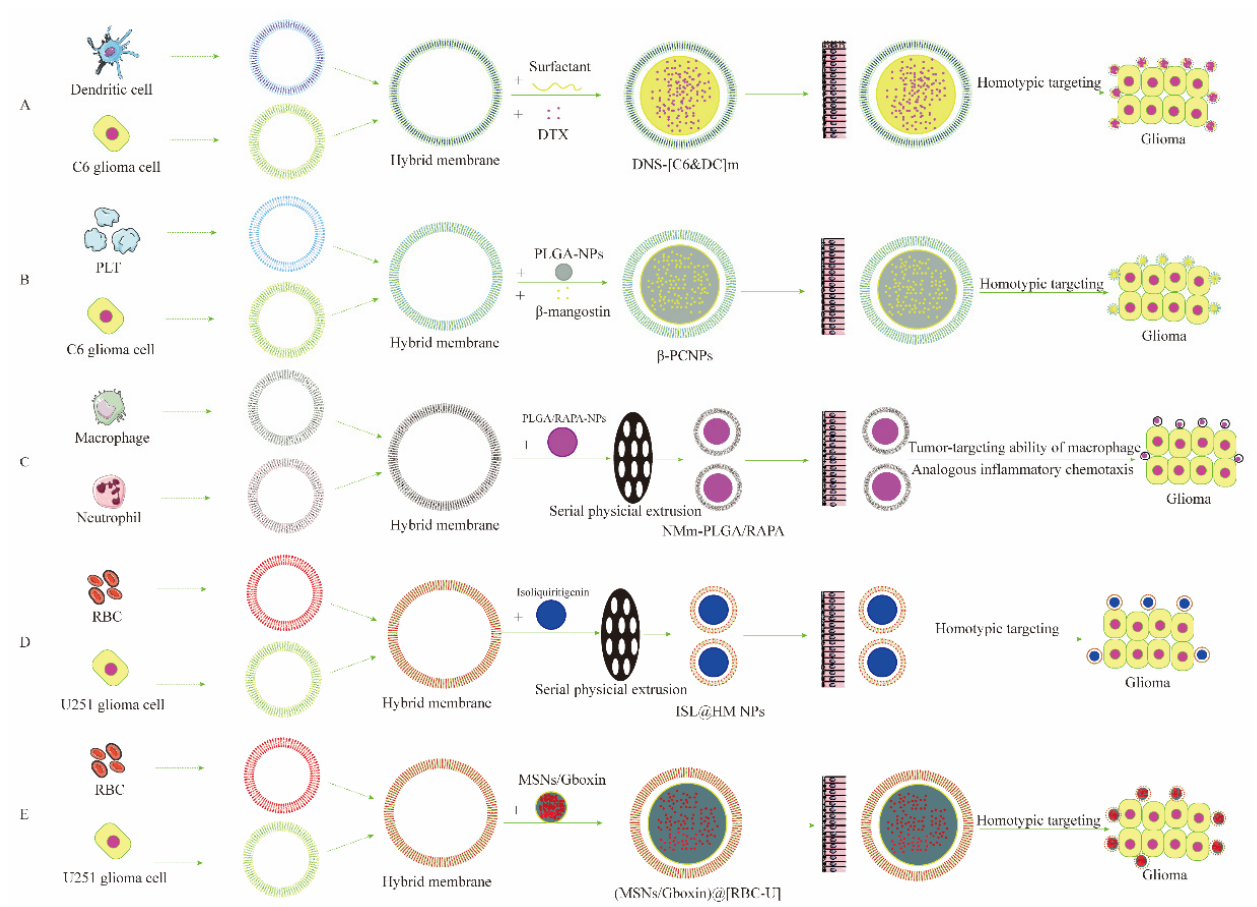
Figure 3. The preparation and characterization of hybrid-cell-membrane-coated nanoparticles for ND drug delivery. ( A ) The preparation and characterization of DNS-[C6&DC]m for glioma drug delivery; ( B ) the preparation and characterization of β -PCNPs for glioma drug delivery; ( C ) the preparation and characterization of NMm-PLGA/RAPA for glioma drug delivery; ( D ) the preparation and characterization of ISL@HM NPs for glioma drug delivery; and ( E ) the preparation and characterization of (MSNs/Gboxin)@[RBC-U] for glioma drug delivery.